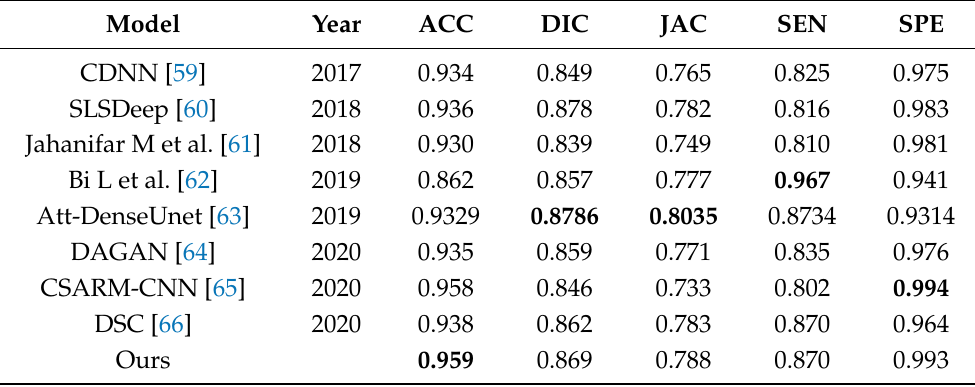
Table 11. Performance evaluation of accuracy, Dice coefficient, Jaccard coefficient, sensitivity, speci- ficity, and performance of different modules and CSFAG modules on the ISIC-2017 data set. Bold data indicates that the value is the maximum value in this indicator.